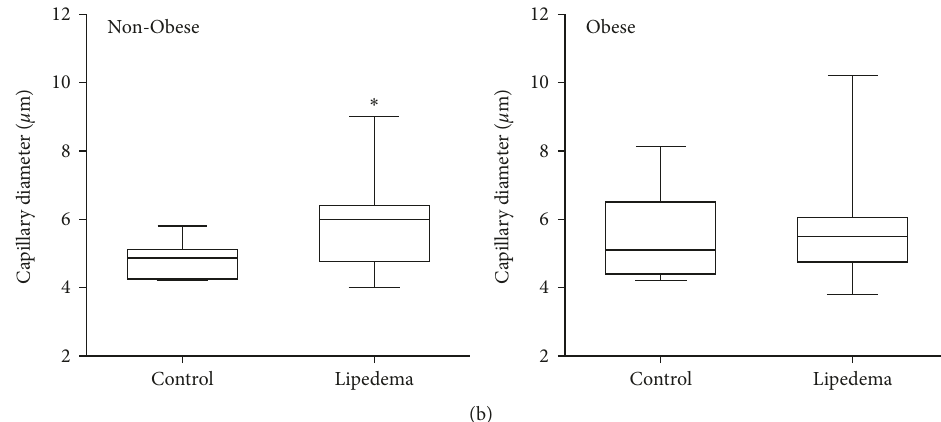
Figure 4: Quantification of capillaries in the leg fat of Non-Obese and Obese participants with and without lipedema (controls). Box and whisker plots of the (a) number of capillaries per adipocyte and (b) capillary diameter measured in Obese and Non-Obese Lipedema participants compared to Controls. Non-Obese groups (Control n